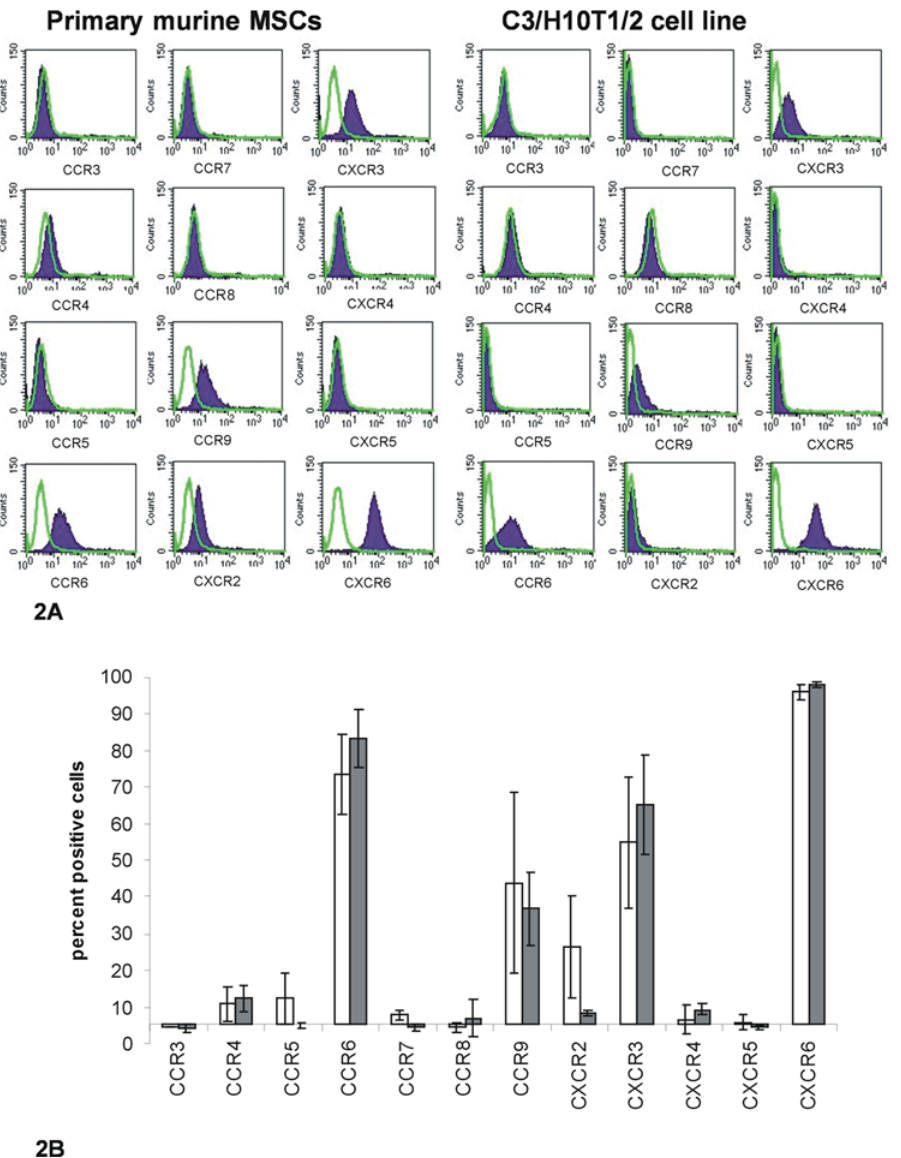
Figure 2. Analysis of chemokine receptor expression on murine MSCs. A Flow cytometry analysis of chemokine receptor expression on the surface of primary murine MSCs and the C3H/10T1/2 cell line. Chemokine receptor antibody staining is represented by the filled histogram; isotype control staining is represented by the green line. Histograms are representative of three independent experiments, performed at three different passages. B Mean percentage positive MSCs is shown for each receptor ( 6 SE, n=3) detected by flow cytometry on the surface of primary murine MSCs (white bars) and the C3H/10T1/2 cell line (grey bars).